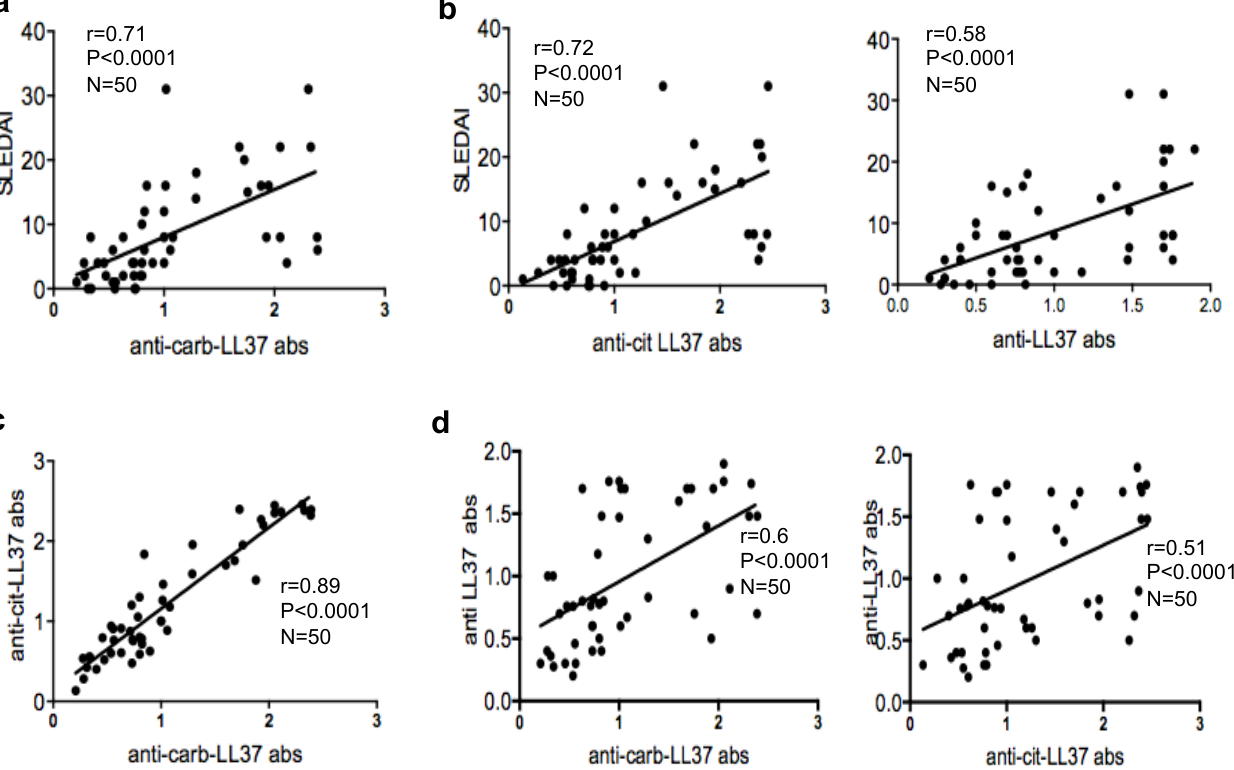
Figure 2. Anti-carb-LL37 antibodies correlate with disease activity. ( a ) Anti-carb-LL37 and ( b ) anti native LL37/anti-cit- LL37-antibody response (OD), (shown for comparison), plotted against systemic lupus erythematosus diseases activity index (SLEDAI) values. Spearman’s coefficient “r”, significance p , sample size N, indicated. ( c ) Anti-carb-LL37 and anti- native/cit-LL37 antibody responses, plotted against anti-cit-LL37 ( d ) or anti-carb/cit/native LL37-responses, as indicated. Spearman’s r, significance p , sample size N,